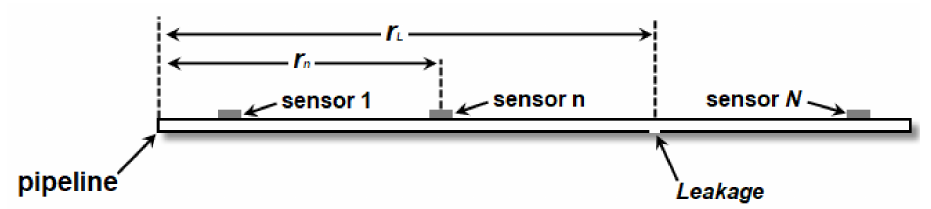
Figure 1. Model of the proposed